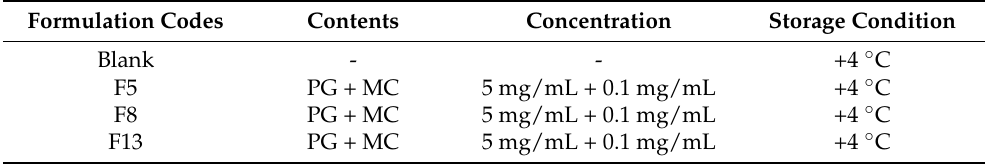
Table 11. Contents and quantities of formulations used for cell culture.